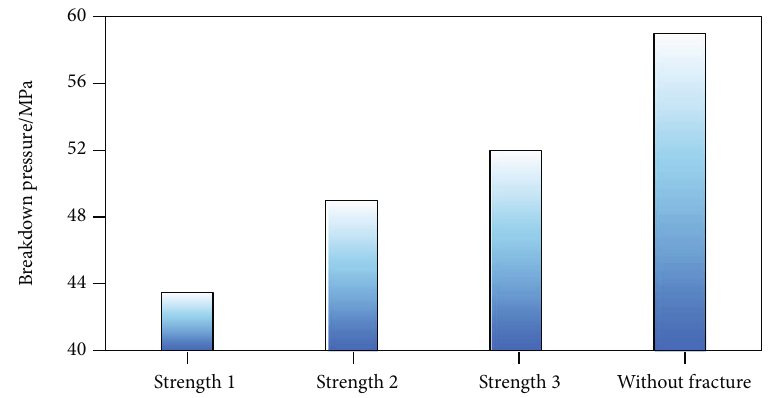
Figure 20: Breakdown pressure with di ff erent strengths of natural